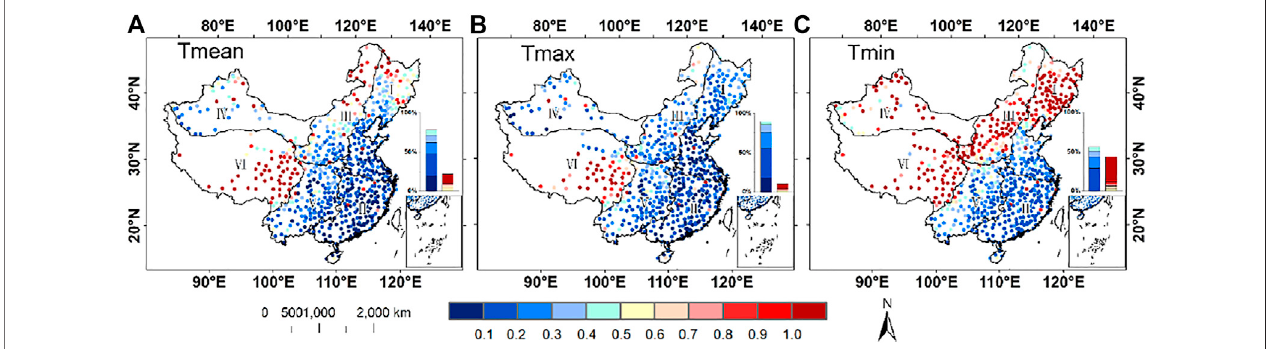
FIGURE 2 | DISO performance over China from 1979 to 2020 for T mean (A) , T max (B) , and T min (C) .